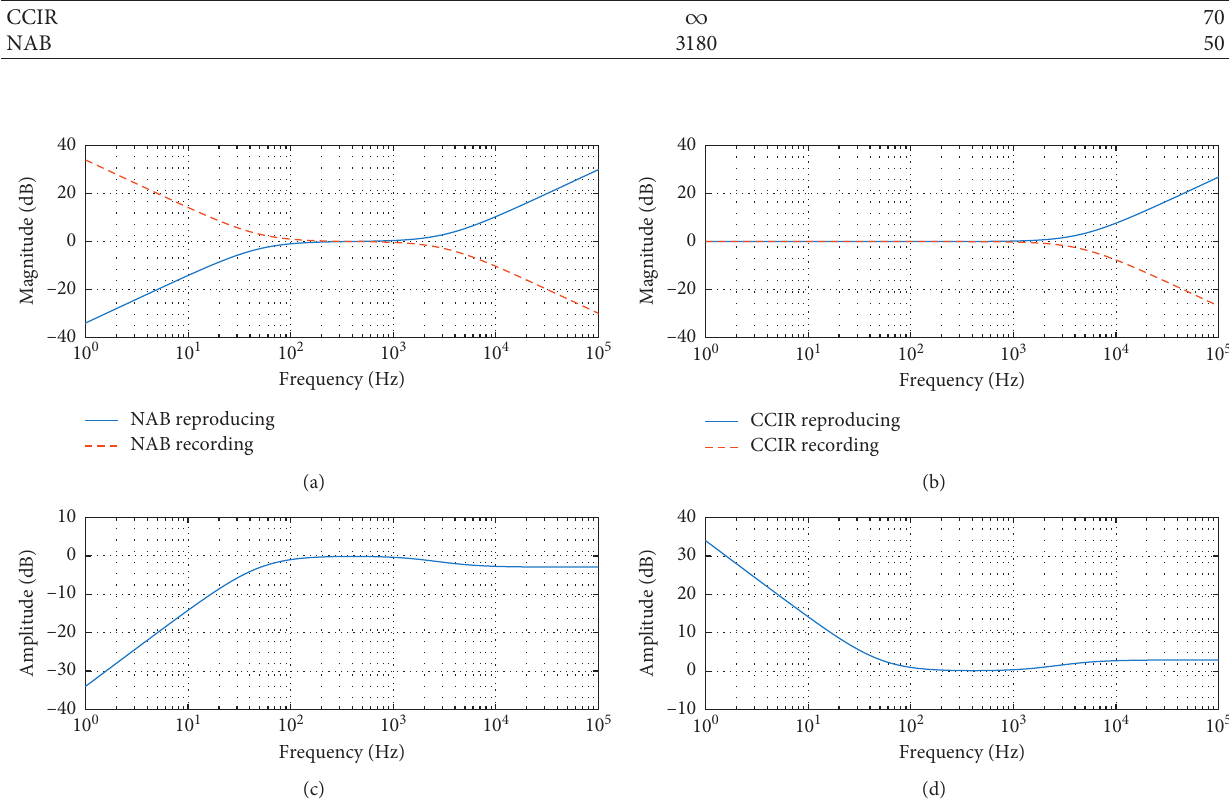
Table 1: Time constants of the CCIR and NAB postemphasis curves at 7.5ips. Equalization standard